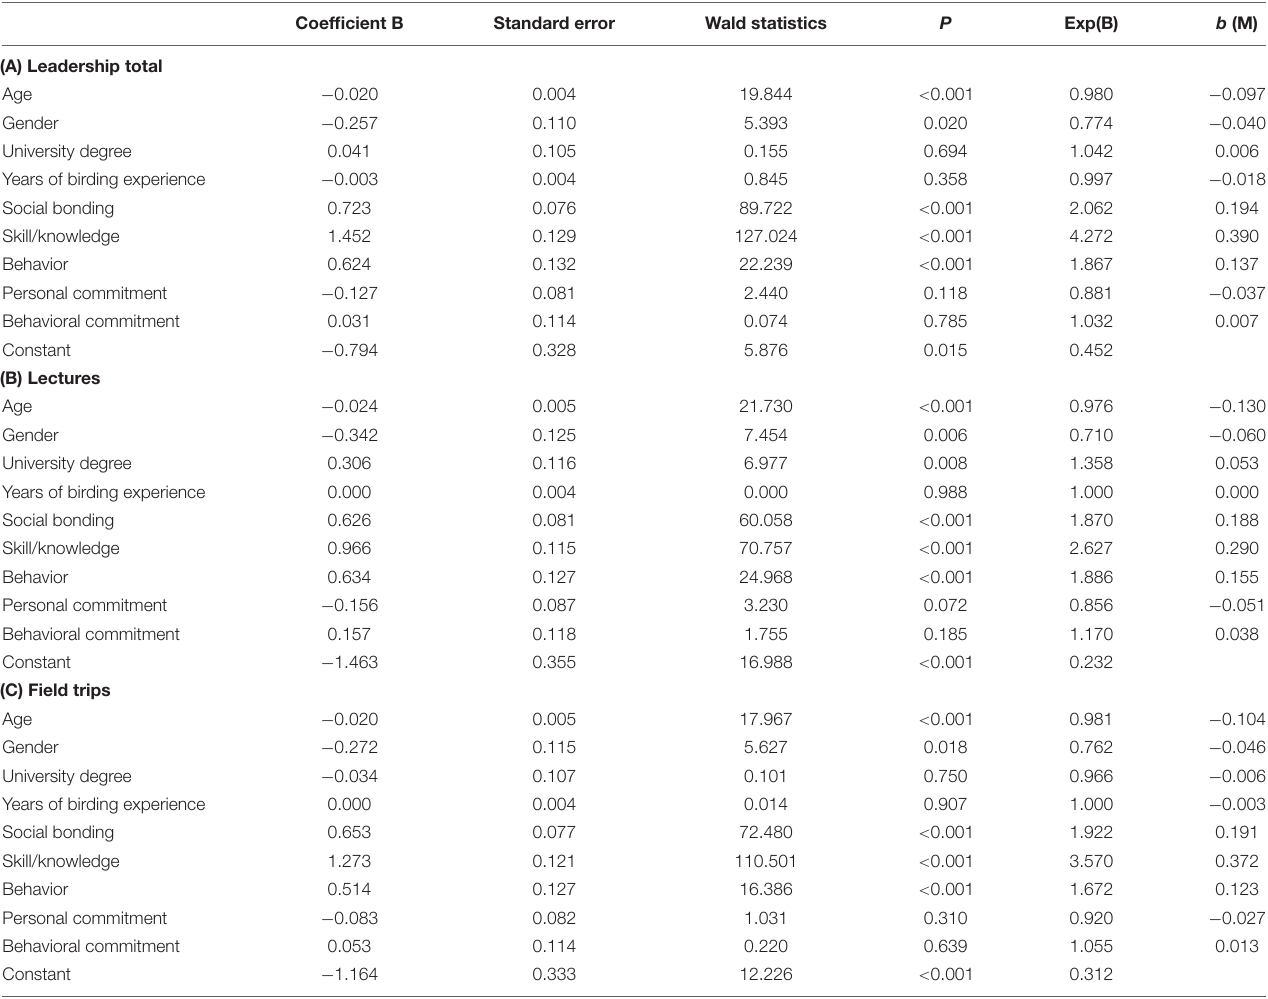
TABLE 3 | Predictors of leadership in